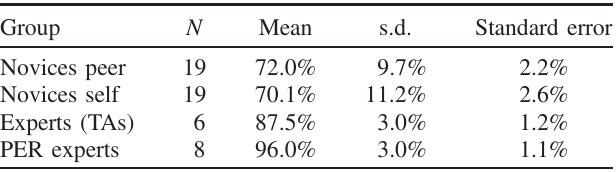
JUDGMENTS OF PHYSICS PROBLEM TABLE V. Accuracy scores for the 28 questions used in experiment 2. Note that the 28 questions selected for the expert novice study were selected based upon high accuracy score among the PER experts.